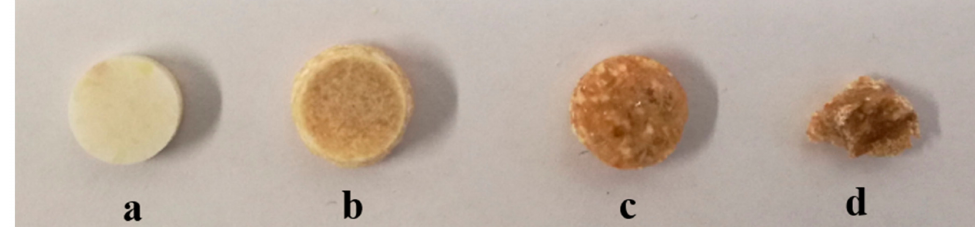
Figure 5. Physical appearance (color) for representative samples of VOR-PHP tablet compacts ( a ) unexposed (initial); and after storage ( b ) 1 d ( c ) 5 d ( d ) 10 d, at 40 ◦ C / 75% RH in open state.